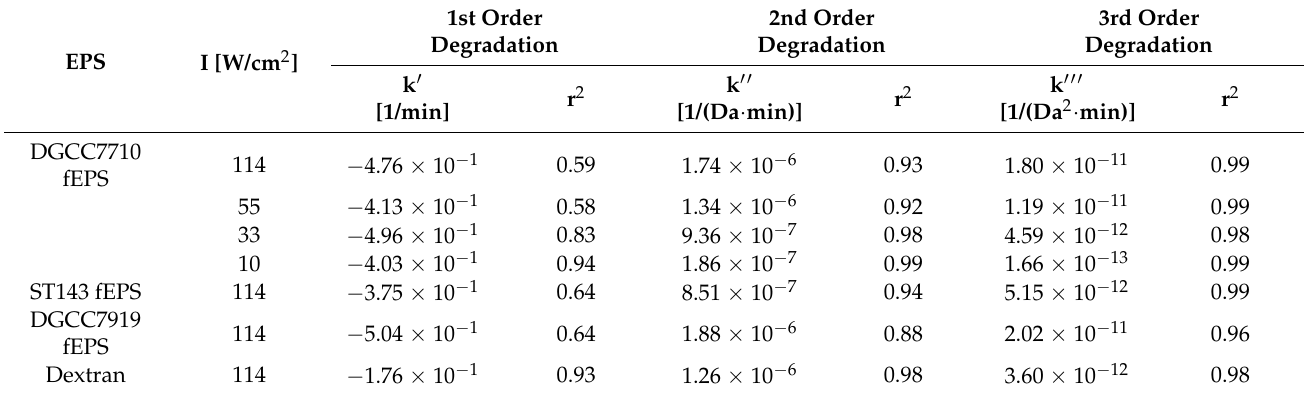
Table 3. Rate constants k (cid:48) , k (cid:48)(cid:48) and k (cid:48)(cid:48)(cid:48) of different degradation models, applied to ultrasonicated EPS at different power density I [W/cm 2